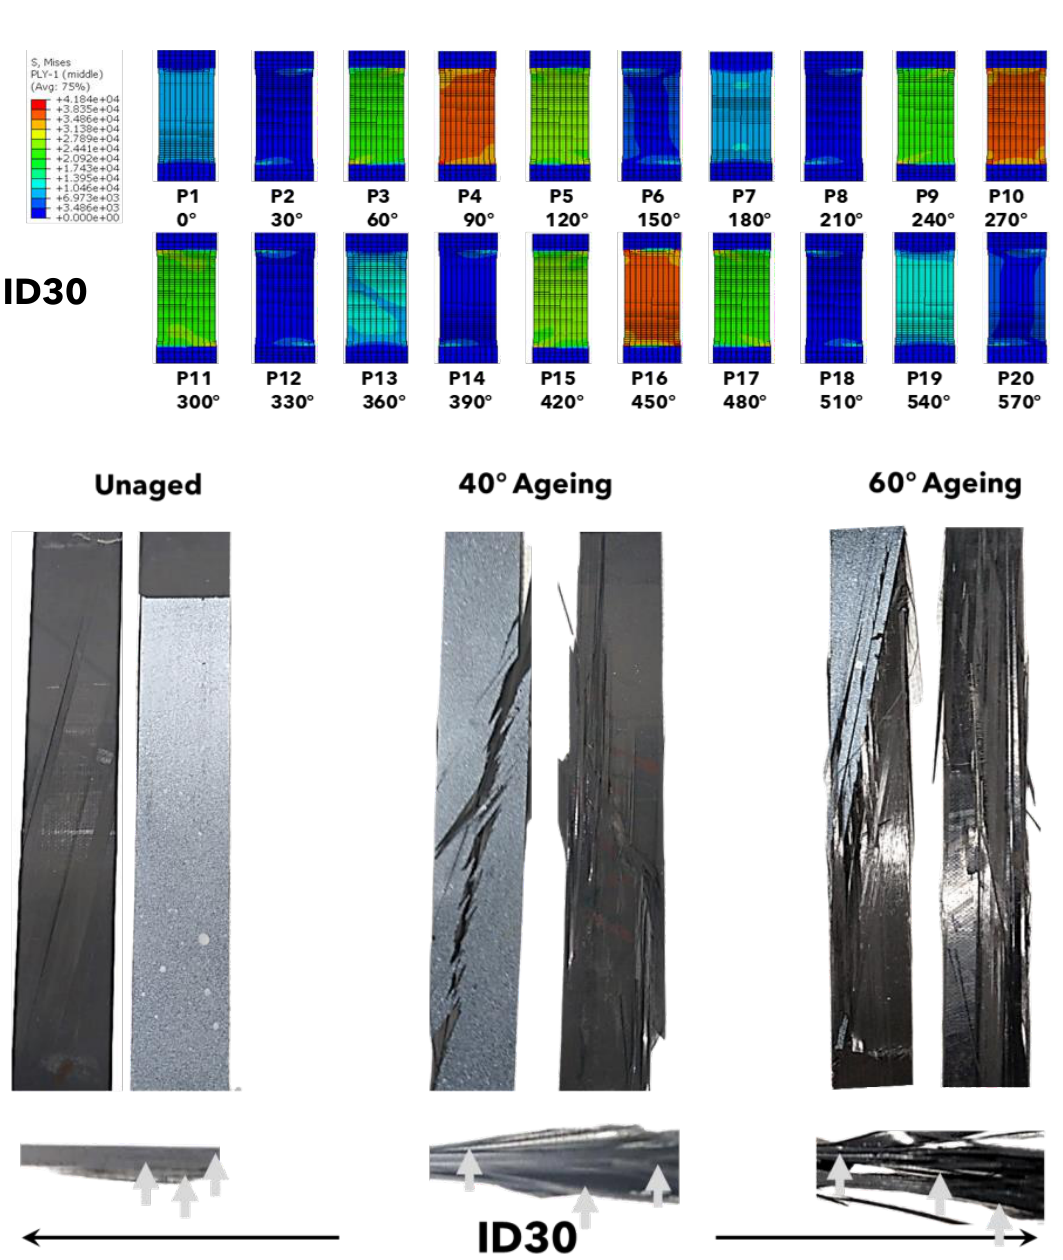
Figure 11. Stress (von Mises) distributions in individual dry plies predicted using the Hashin failure model, for ID30 composites ( top ), front and back face fractures from representative dry, 40 ◦ C, and 60 ◦ C aged samples ( middle ), and side view fractures from representative dry, 40 ◦ C, and 60 ◦ C aged samples ( bottom ), with arrows indicating the primary areas of fracture